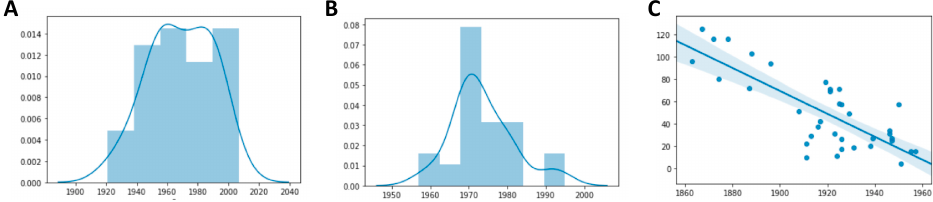
Figure 3. ( A ) Frequency distribution of the transition from one- to two-column layouts in the present sample of journals. The year the change in format occurred is reported on the x axis. ( B ) Frequency distribution of adoption of abstracts in the present sample. The year the change in format occurred is reported on the x axis. ( C ) Correlation plot between the journal foundation ( x axis) and the time span to the adoption of a two-column layout ( y axis). There is a clear correlation trend: younger